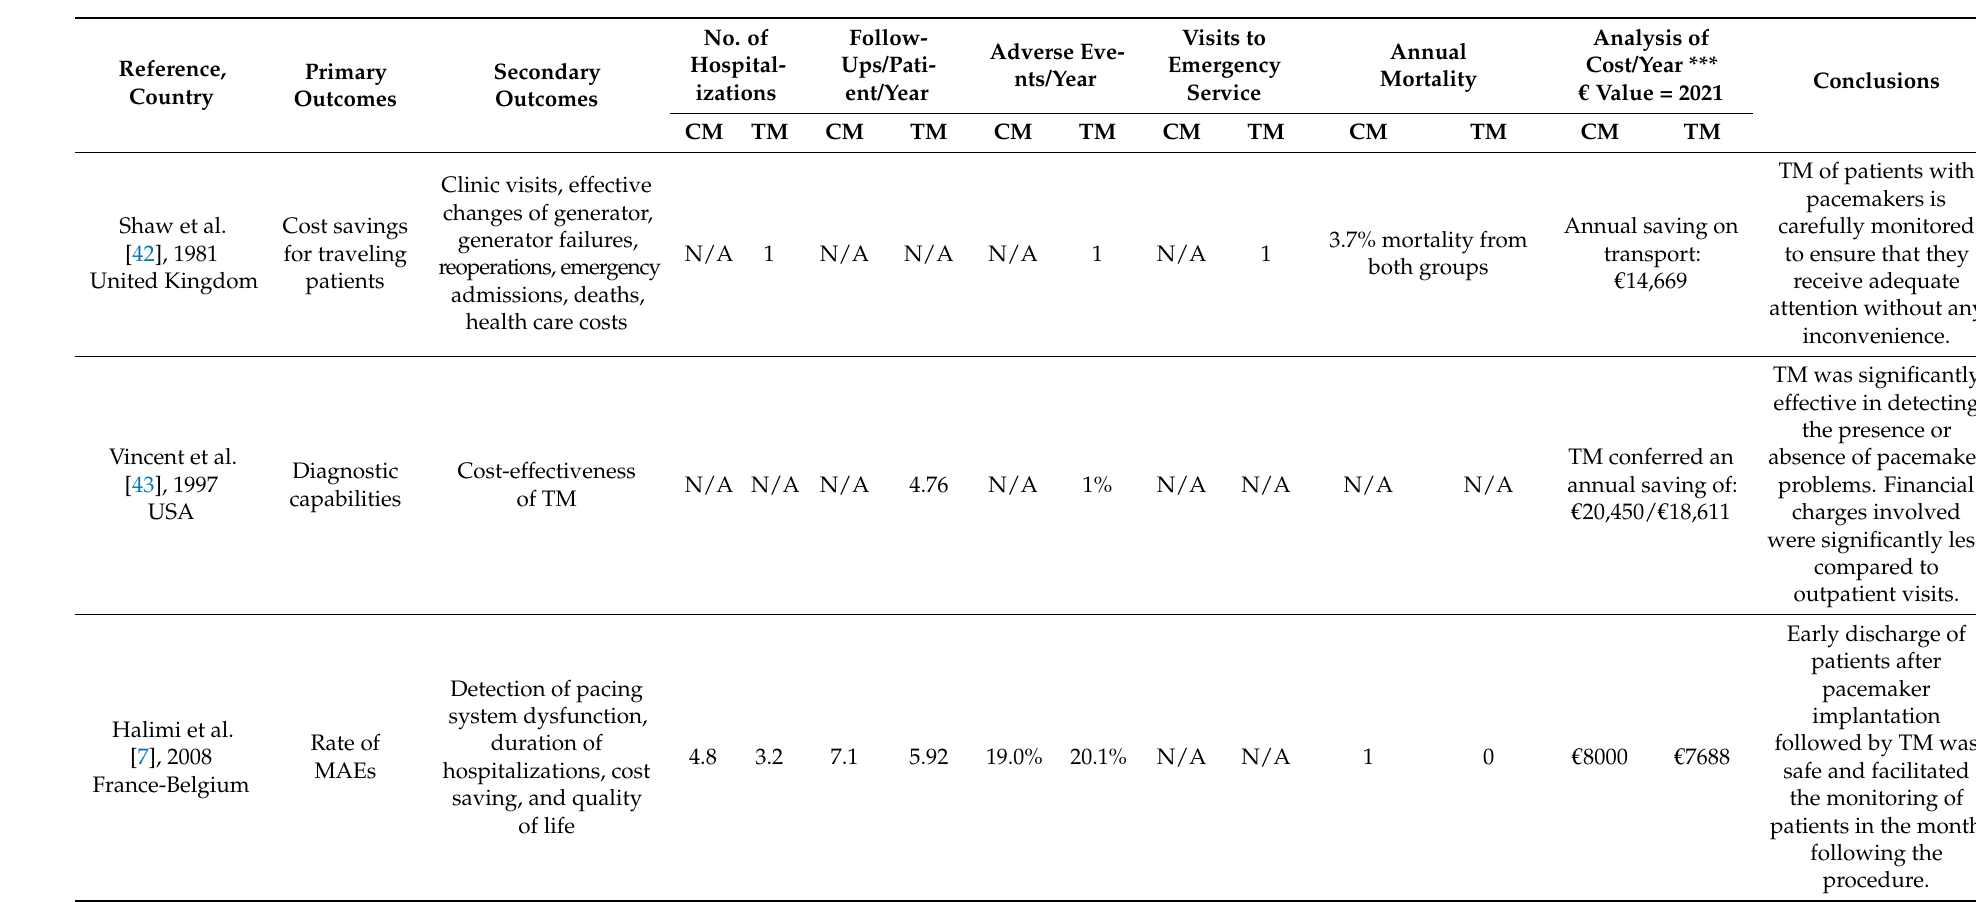
Table 2. Analysis of main outcomes, inputs, and